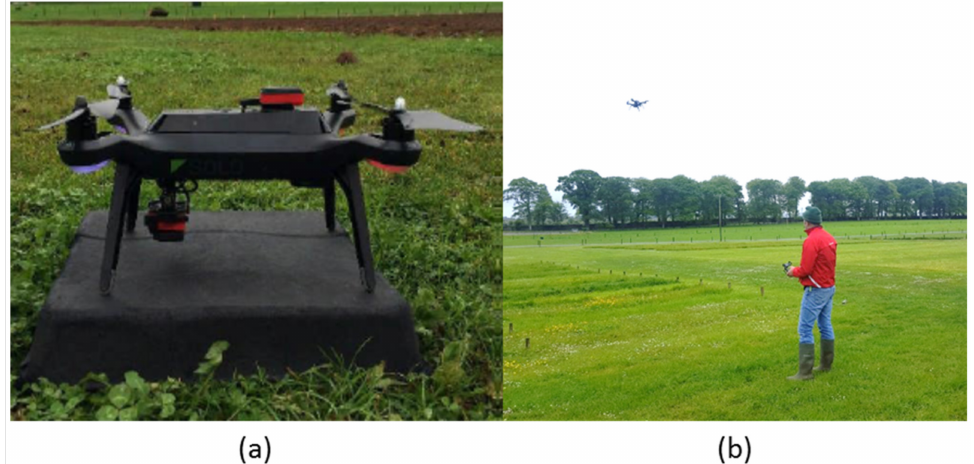
Figure 9. ( a ) UAV with multispectral sensor and ( b ) UAV plot sensing fly over from study by Askari et al.